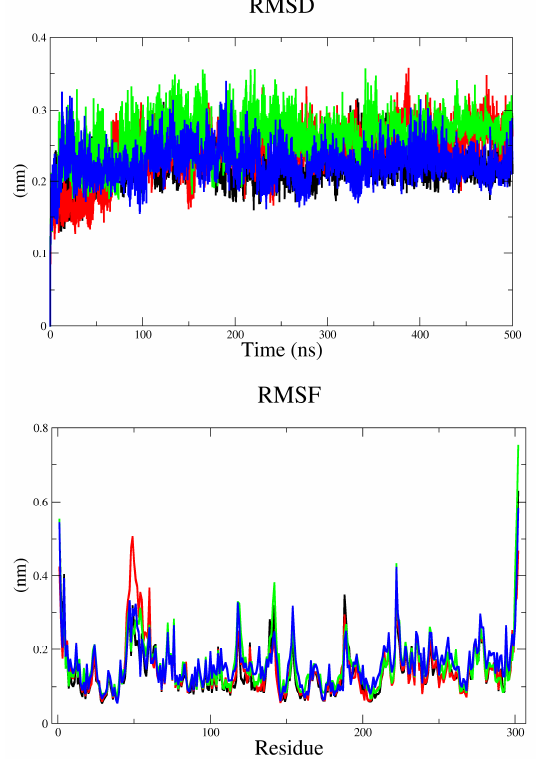
Figure 2. Top: C- α RMSD profiles along the L01–M pro WT, (mean: 0.22, SD: 0.02, black), L02–M pro WT (mean: 0.24 and SD 0.04, red), L01–M pro O (mean: 0.26 and SD: 0.03, green) and L02–M pro O (mean 0.22 and SD 0.02, blue) whole simulation complexes. Bottom: residue root-mean-square fluctuation (RMSF) profiles along the L01–M pro WT, (black), L02–M pro WT (red), L01–M pro O (green) and L02–M pro O (blue) whole simulation complexes.